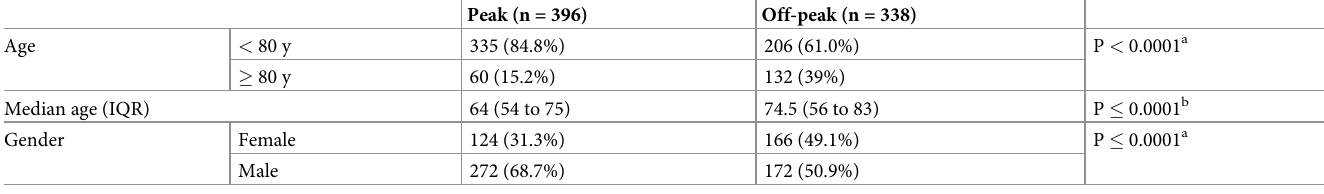
Table 1. Characteristics of the COVID-19-positive patient population examined.